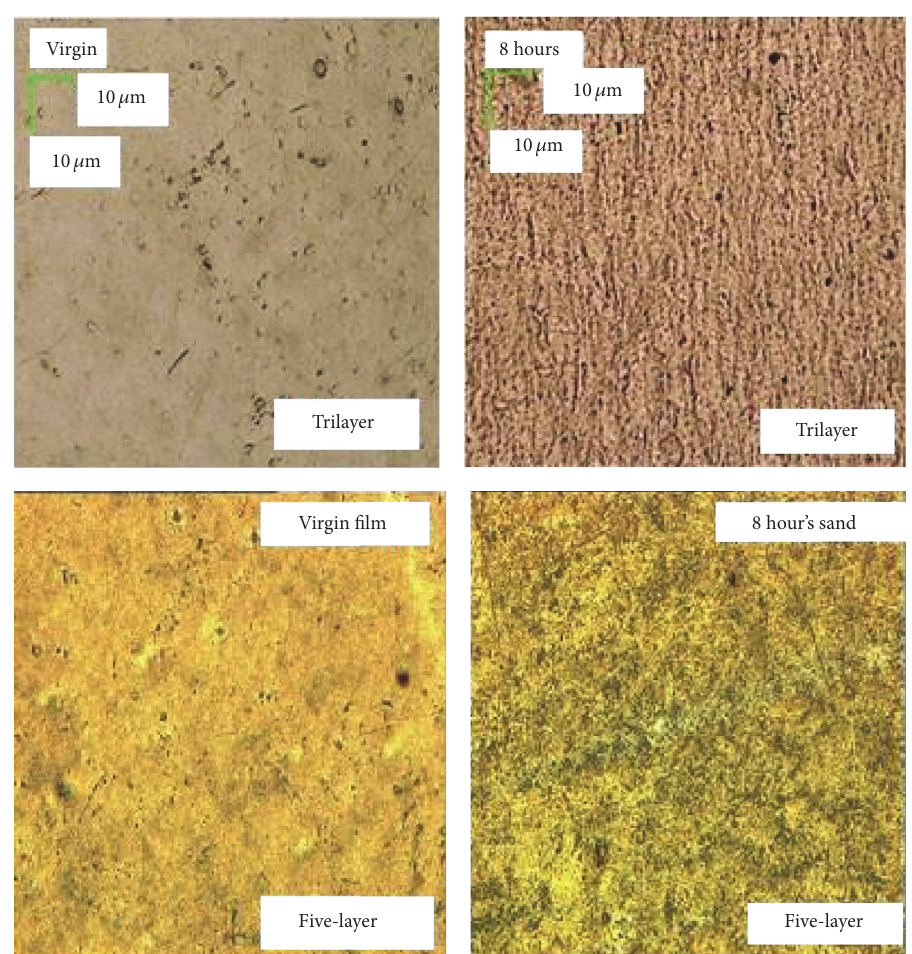
Figure 2: Microphotographs of the surface of the five-layer and trilayer films before (virgin) and after 8 hours of exposure to sand wind at 40 ∘